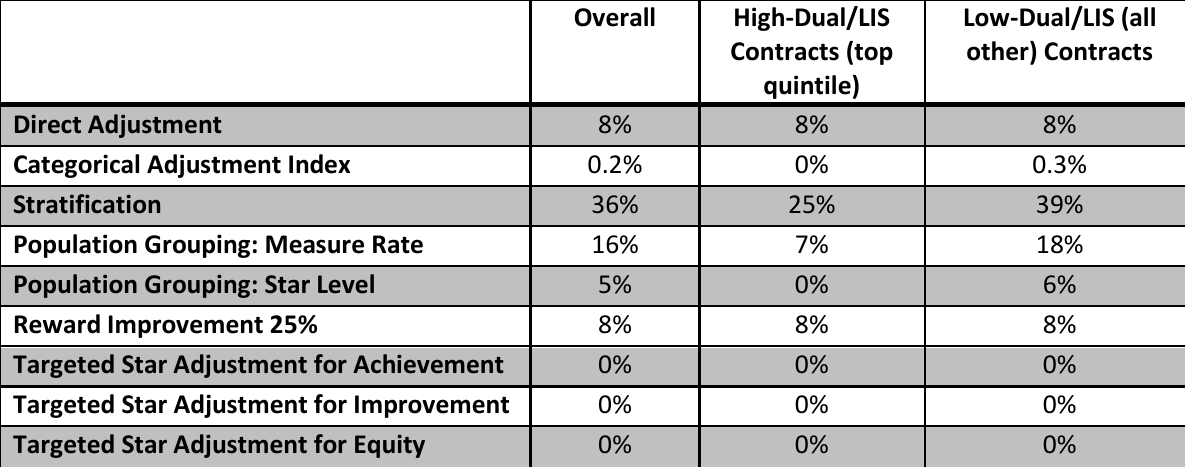
Table 8.18b: Net Impact of Policy Options: Percent of Contracts that Lose at Least Half a Star